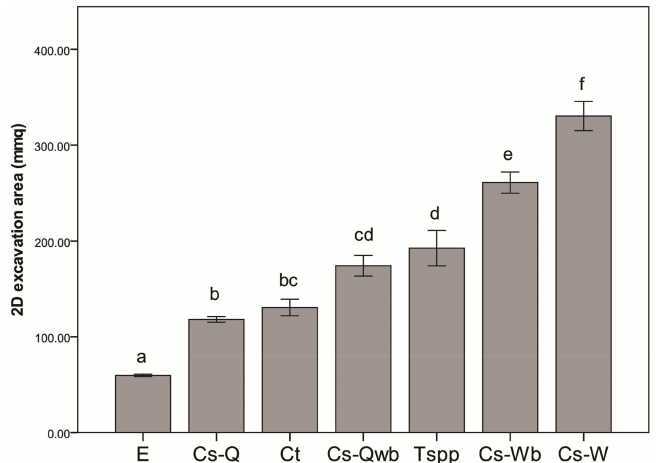
Figure 7. 2D excavation area according to ant species and colony composition. E = empty, Cs-Q = Cr. scutellaris queen only, Ct = Co. truncata , Cs-Qwb = Cr. scutellaris queen + workers + brood, Tspp = Temnothorax spp., Cs-Wb = Cr. scutellaris workers + brood, Cs-W = Cr. scutellaris workers only. The SE interval is shown for each bar. The bars with the same letter are not statistically di ff erent (One-way ANOVA, see text for further details).